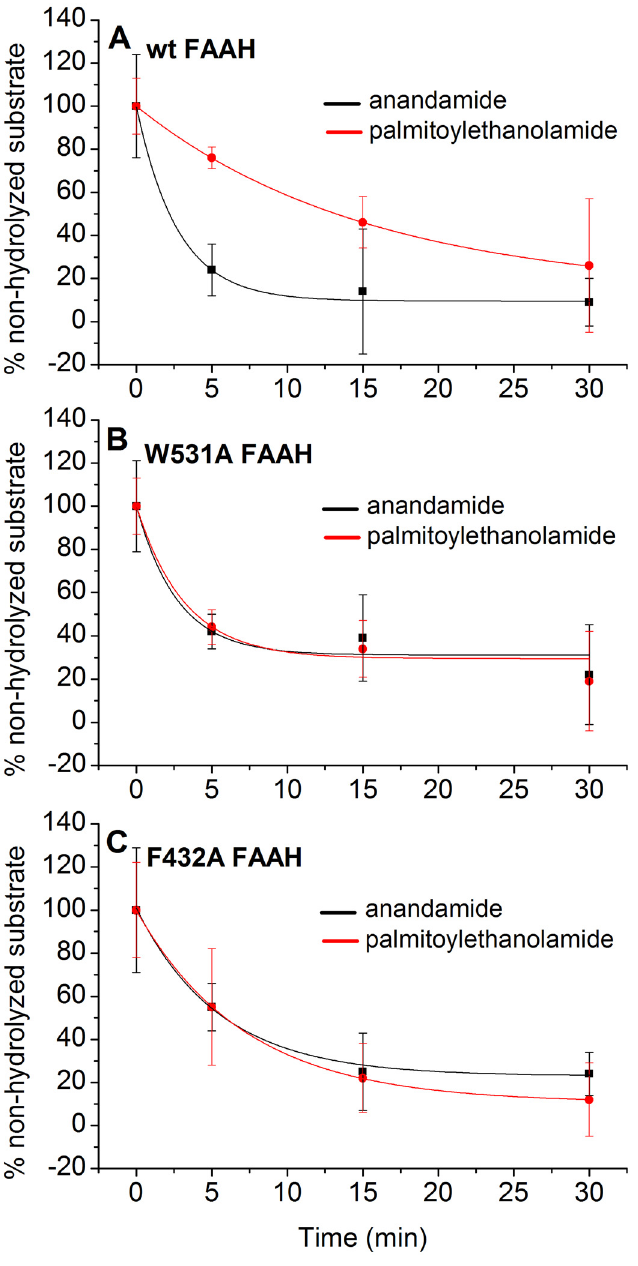
Fig 6. Competition assays performed for the wt (A), W531A (B), and F432A (C) proteins in the presence of both anandamide (black) and PEA (red). Each set of data was fitted using simple exponential decay functions, whose parameters are reported in S6 Table in S2